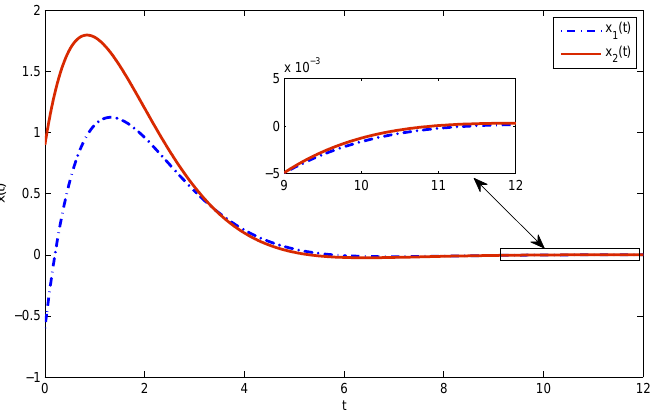
Figure 6. The state trajectories under controllers u 7 ( t ) and u 8 ( t ) . Certainly, the eigenvalues could be adjusted to the maximum edge of the region. By Algorithm 1, the controllers are obtained as below.